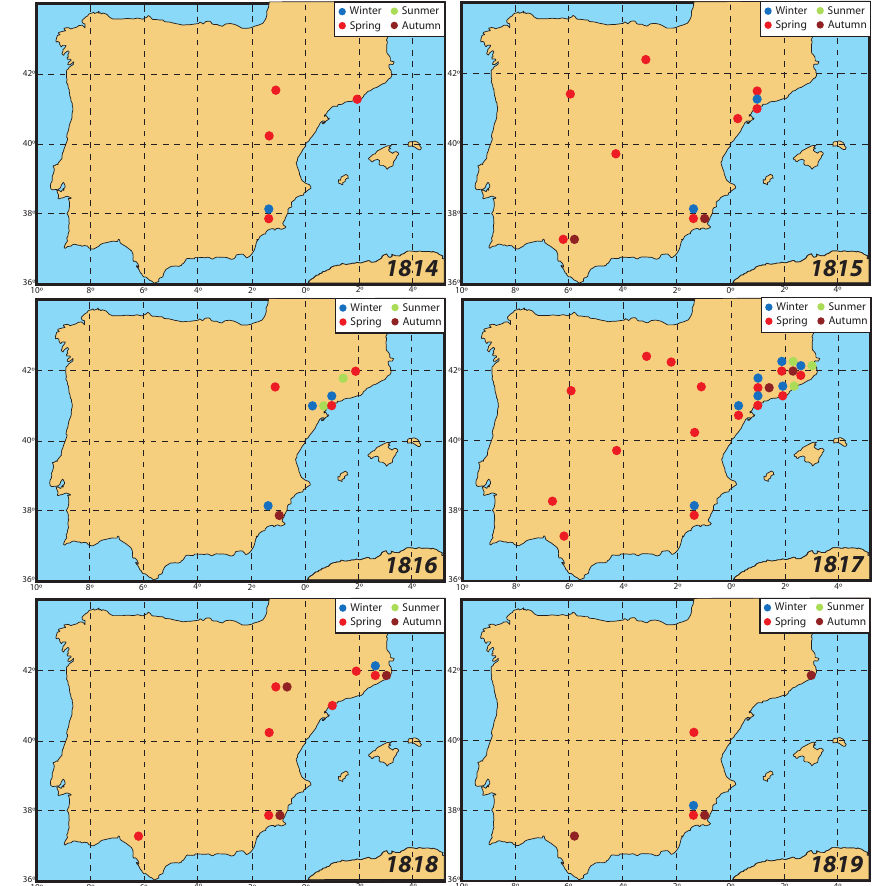
Fig. 6. Geographical distribution of rogations celebrated in Spain between 1814 and 1819.